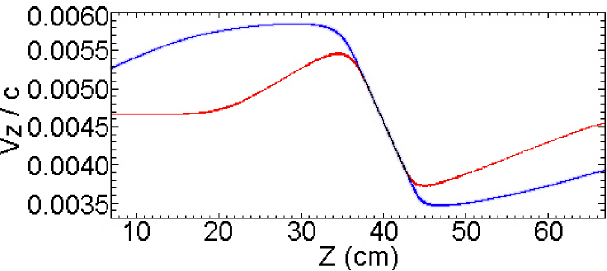
g phase space at t (cid:4) 820 ns for the T FIG. 3. (Color) f z; v z 0 eV beam after application of the sharp waveform (red) and smooth waveform (blue) across the finite-size